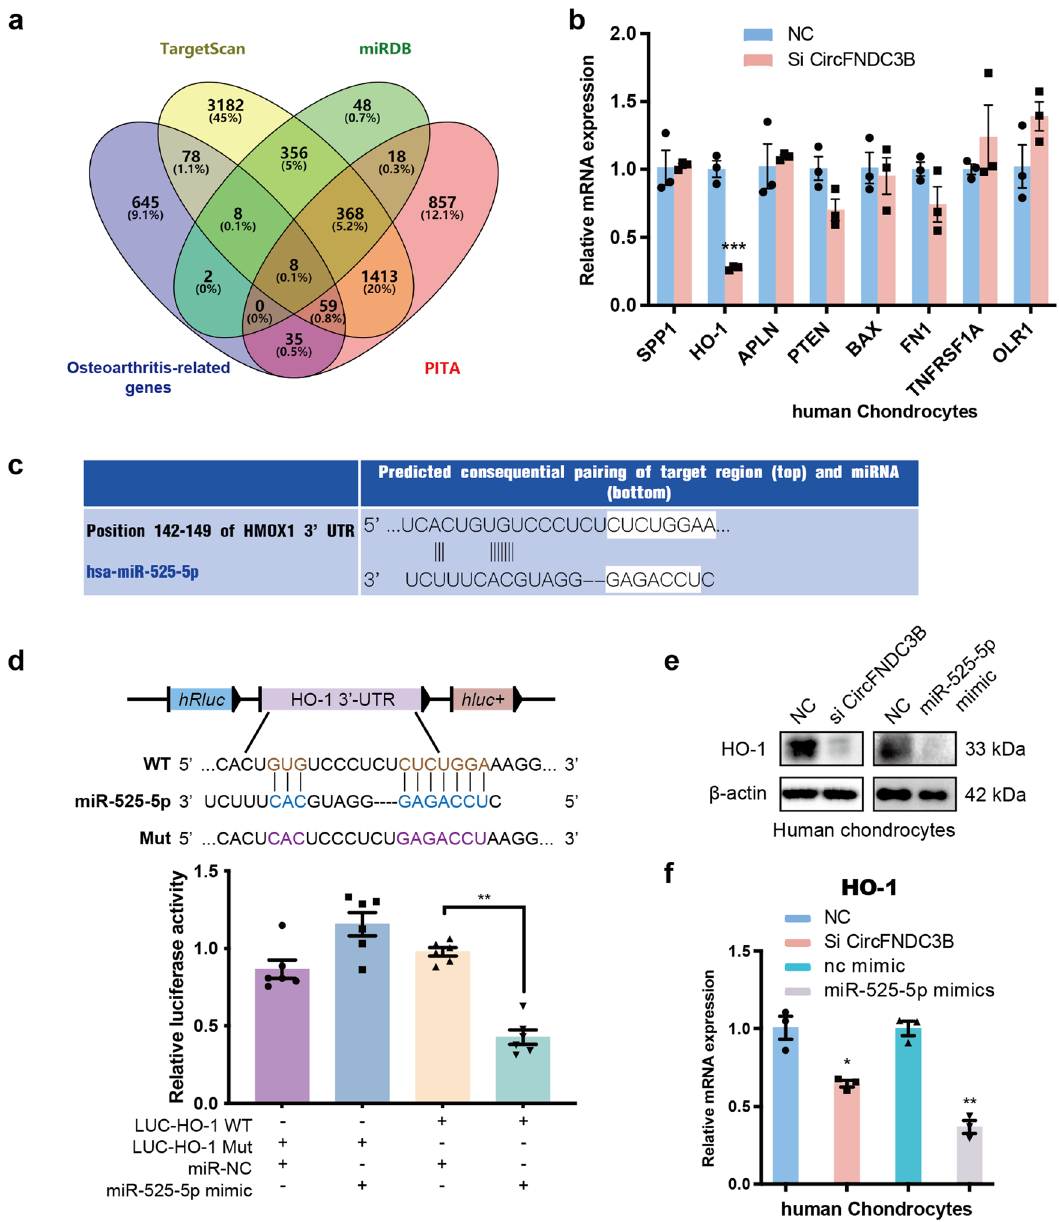
Fig. 6 MiR-525-5p directly targets heme oxygenase 1. a The target mRNAs of miR-525-5p were predicted by miRDB, Targetscan, PITA and Osteoarthritis-related genes. The diagram demonstrated the overlapping results. b RT-qPCR analysis of 8 mRNA candidates in the HCs lysates. ( n = 3). c Schematic illustration showing the predicted binding region of miR-525-5p and HO-1. d Upper panel, schematic illustration demonstrates complementary to the miR-525-5p seed sequence with HO-1. Lowercase letters indicate mutated nucleotides. Lower panel, HEK-293T cells were co-transfected with miR- 145-5p mimics and a luciferase reporter construct containing wild-type (WT) or mutated HO-1. ( n = 3). e , f Western blot and RT-qPCR analysis of HO-1 in HCs after treated with si-CircFNDC3B or miR-525-5p mimic. ( n = 3). Mean ± SEM; *p < 0.05; **p < 0.01; ***p < 0.001 by Student ’ s t